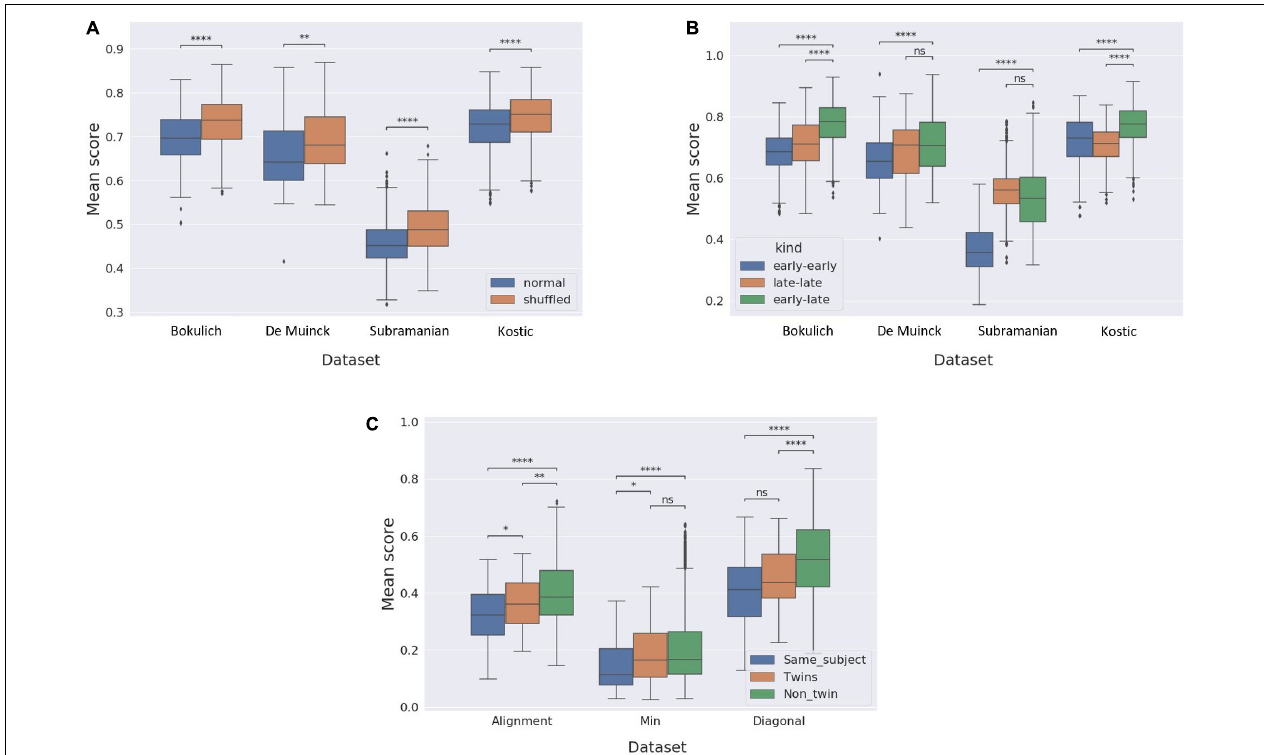
FIGURE 2 | Alignment score as an informative similarity measure. (A) Box plot comparing the alignment scores of all pairs of subjects in each dataset to the alignment scores of all pairs of subjects after shuffling the order of samples. (B) Box plot comparing the alignment scores of early halves of trajectories aligned to each other (“early-early”), late halves aligned to each other (“late-late”), and early halves aligned to late halves (“early-late”) in each of the datasets. (C) Box plot comparing the alignment scores of all pairs of subjects originating in the same trajectory to the alignment scores of trajectories of pairs of twins and the alignment scores of non-related individuals, in the Subramanian dataset. ns: p > 0.05; ∗ p ≤ 0.05; ∗∗ p ≤ 0.01; ∗∗∗ p ≤ 0.001; ∗∗∗∗ p <